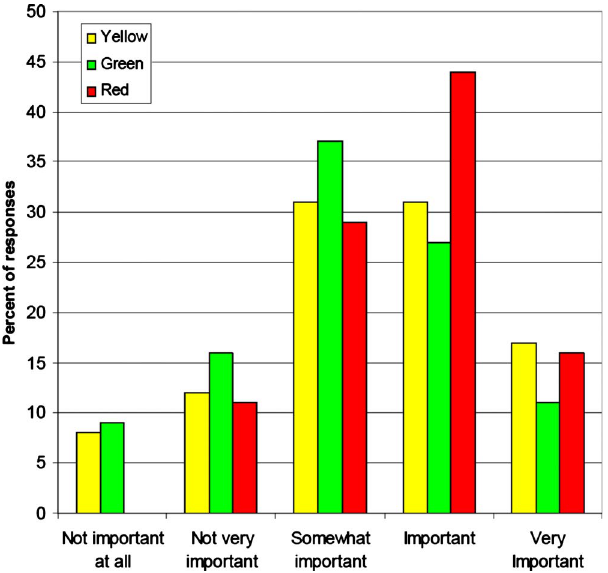
FIG. 8. (cid:1) Color (cid:2) Example question—distribution of student re- sponses to the importance of articulating their